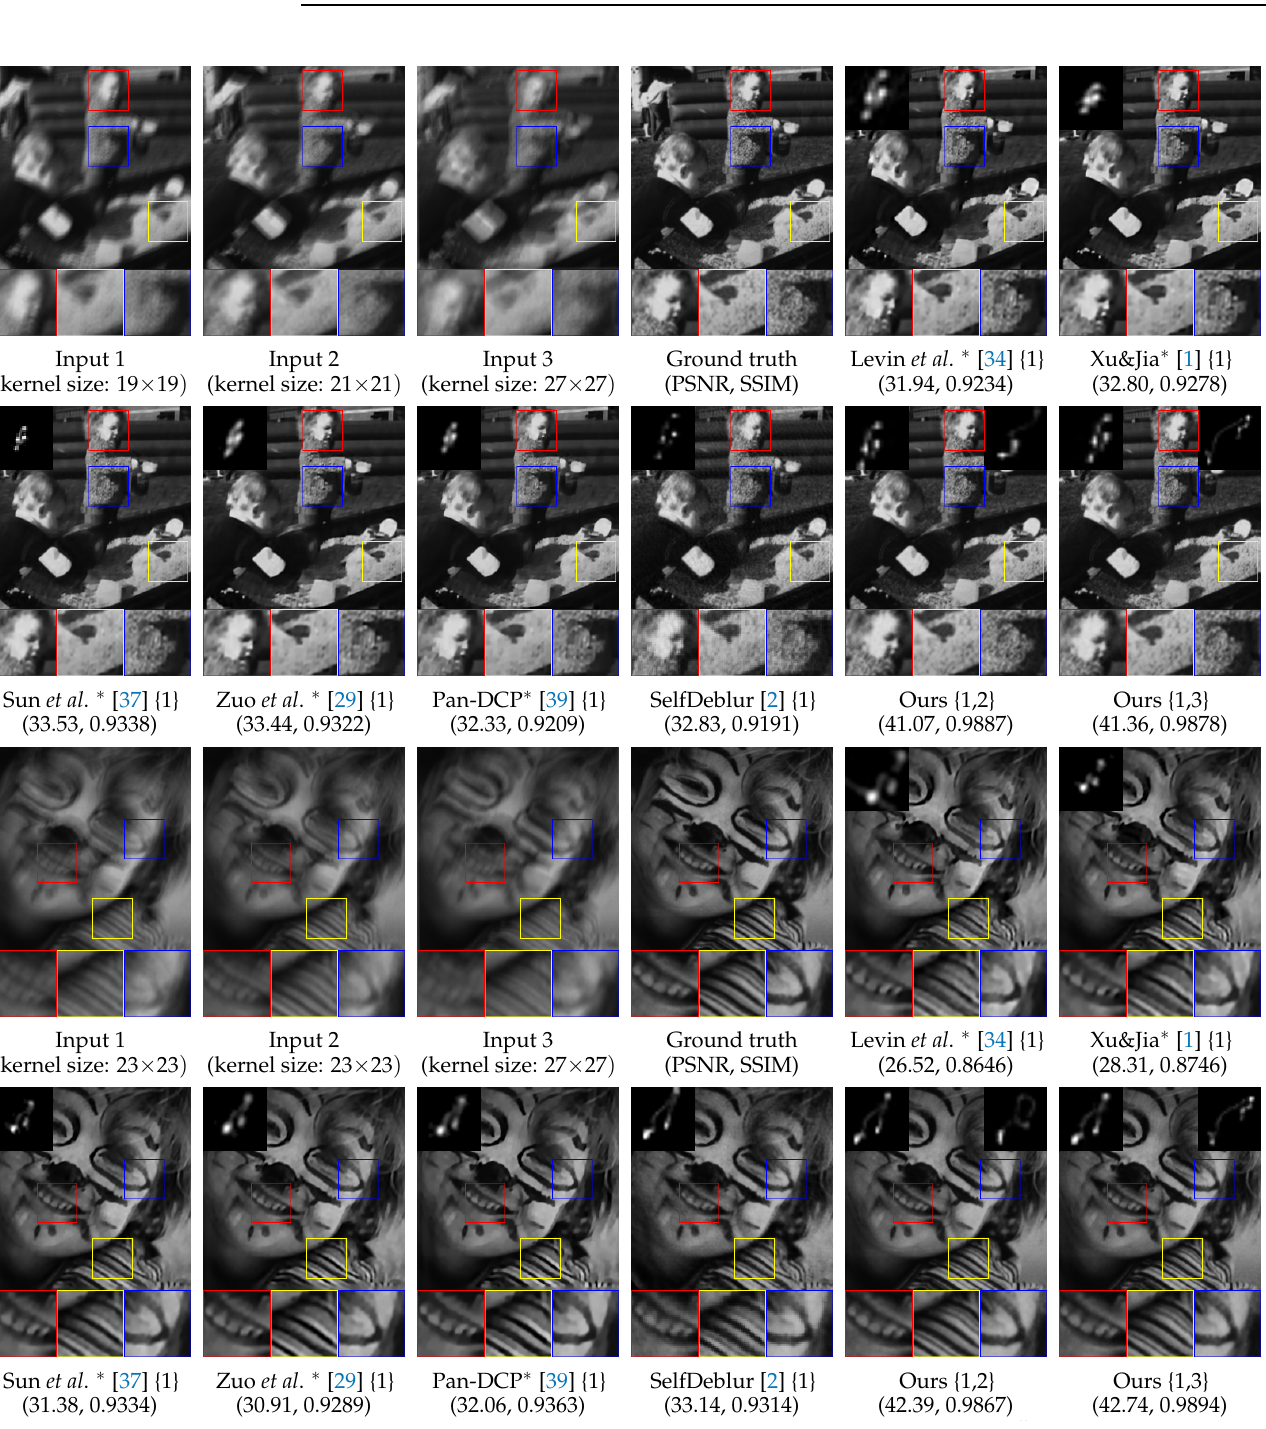
Figure 3. Qualitative comparisons on the Levin test set [33]. * indicates that the method uses the non-blind deconvolution method of [34] to produce the final result. The input image for each method is denoted as resulting image when the input images are input 1 and input 2).